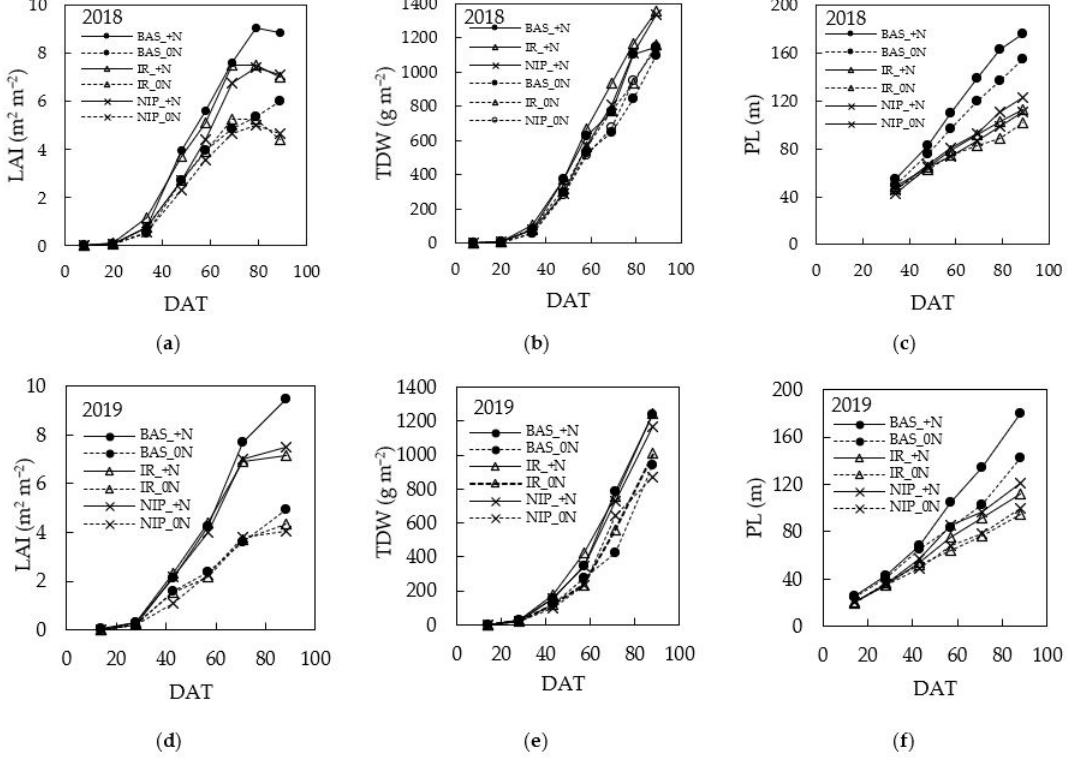
Figure 5. Comparison of seasonal changes in crop growth; ( a , d ) LAI, ( b , e ) TDW and ( c , f ) PL at various days after transplanting (DAT) in 2018 and 2019 for three rice cultivars: Basmati370 (BAS), IR64 (IR) and Nipponbare